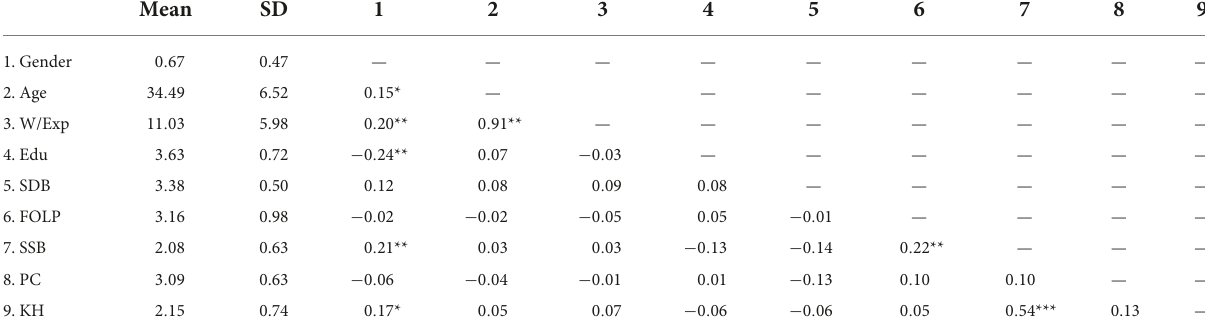
TABLE 2 Descriptive statistics and correlation analysis.